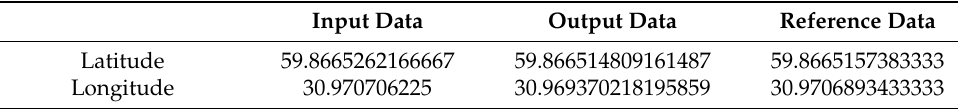
Table 3. Results of the first neural network.